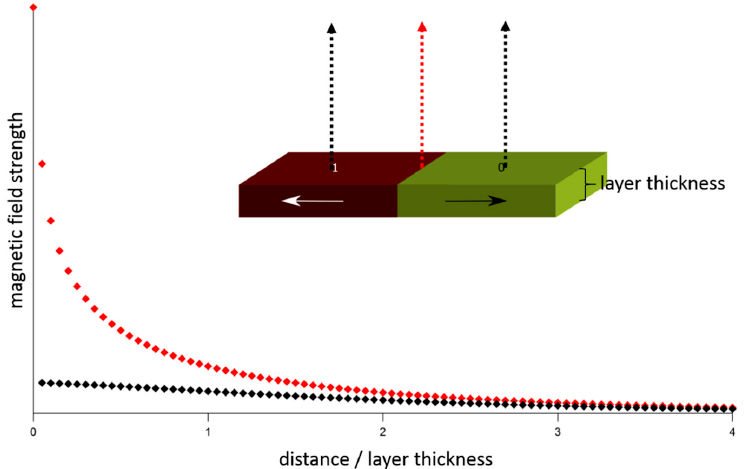
Figure 7. Magnetic stray field strength as a function of the distance from the layer surface, calculated for a bit structure with opposing magnetic moments as shown in the sketch. The arrows in the sketch mark the positions of the stray field calculations (black curve: middle of bits, red curve: interface between bits).